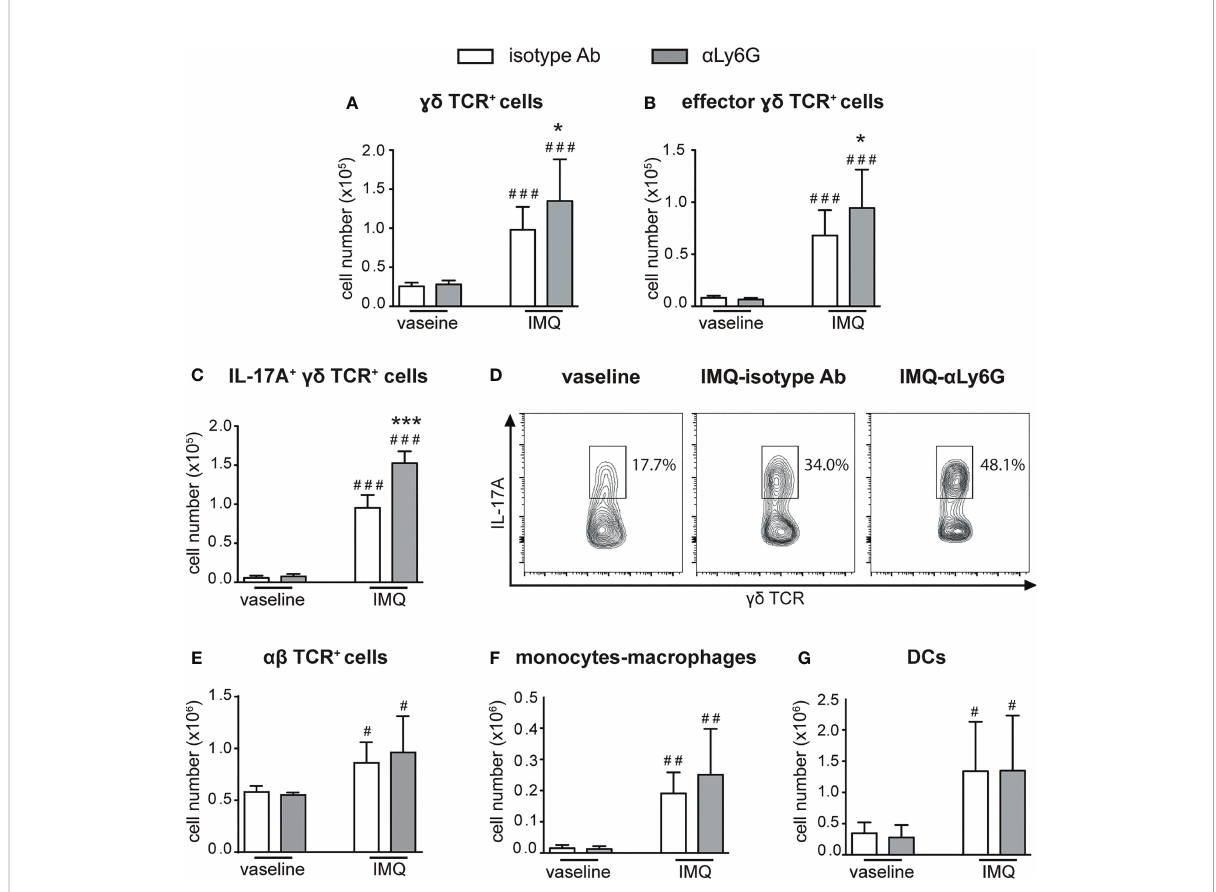
FIGURE 3 In fi ltration of in fl ammatory cells in the draining lymph nodes of IMQ-treated control or neutrophil-depleted mice. The dorsal skin of mice was topically treated with IMQ-containing cream (Aldara ® ) or vaseline for 6 consecutive days. Mice were injected with the depleting antibody a Ly6G or isotype control Ab. Draining lymph nodes were collected and analyzed by fl ow cytometry. Panels report: the number of total (A) and effector (CD44 high CD62L low , B ) gd TCR + cells; the total number (C) or the frequencies (representative FACS plots , D ) of IL-17A-producing gd TCR + cells; the total number of ab TCR + T cells (E) ; the total number of monocytes/M f (CD11b high Ly6G - CD11c low/- MHCII low/- cells plus CD11b high Ly6G - CD11c low / - MHCII high cells) (F) ; the total number of DCs (CD11c +/high MHCII high ) (G) . Data are pooled from 3 separate experiments and are expressed as means ± SD (n = 14-15 mice). Statistical differences of IMQ-treated vs . vaseline-treated mice (#) and IMQ-treated control vs . neutrophil-depleted mice (*) are reported. #/* P ≤ 0.05; ## P ≤ 0.01; ###/*** P ≤ 0.001 by 1-way ANOVA with Bonferroni ’ s